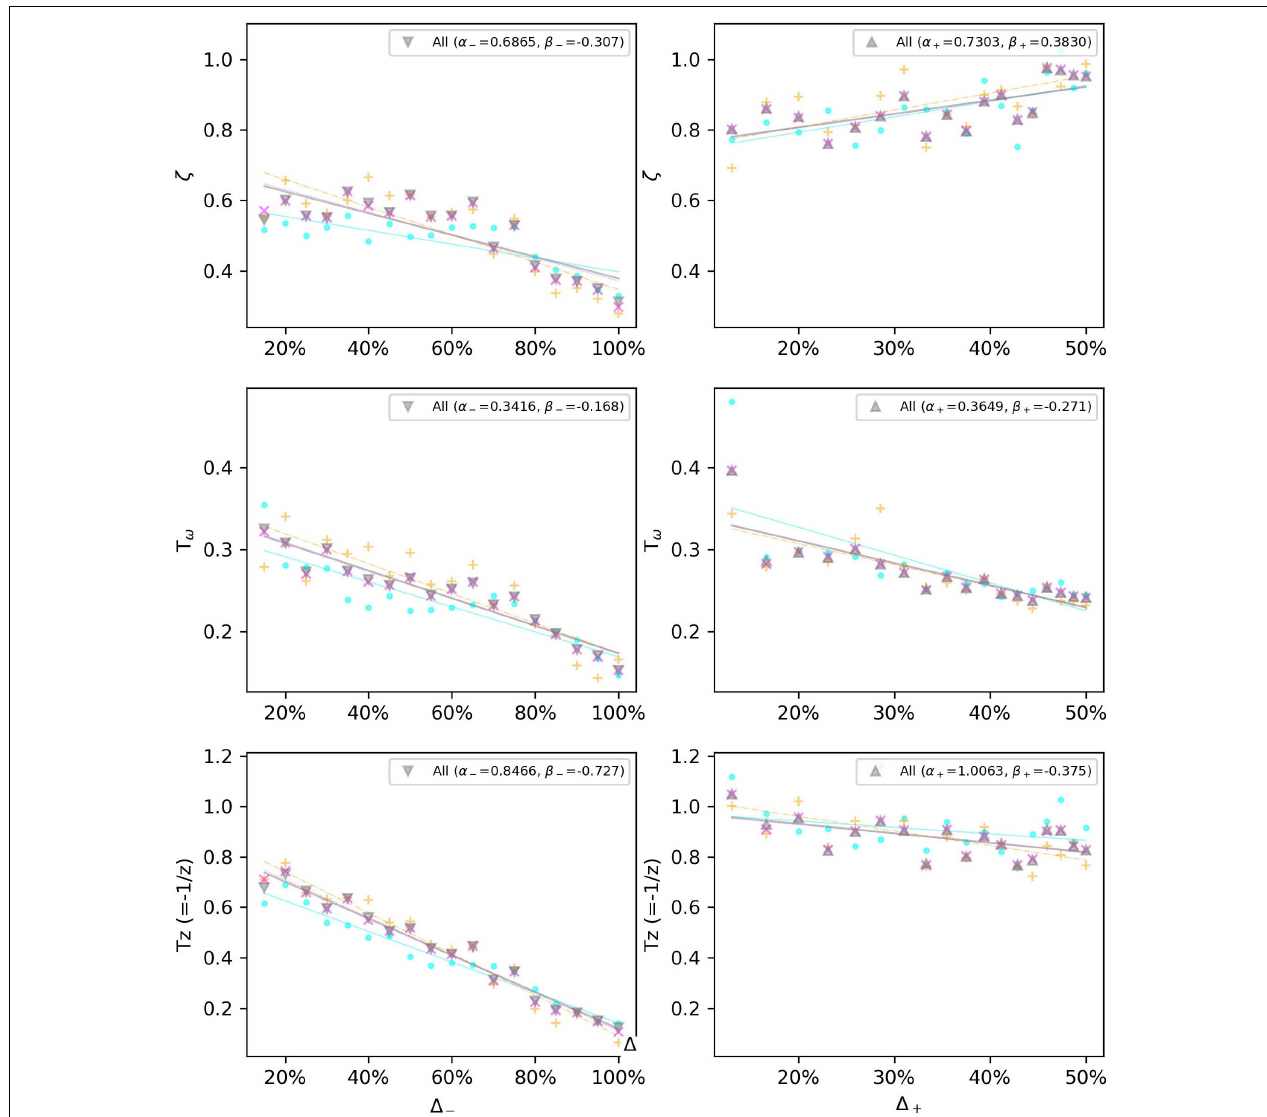
FIGURE 8 | Linear regression estimates for the observed values of the P2DUZ model parameters, i.e., delay ( T D ), damping ratio ( ζ ), oscillation period ( T ω ), and zero (–1/ T Z ), for negative and positive step sizes in the supraliminal range (base tempo = 100